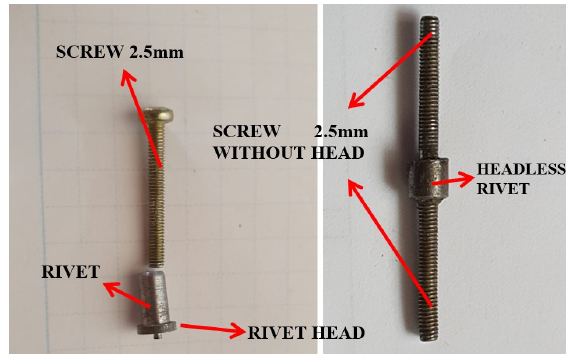
Figure 5. Connector assembly details. NOTE: on the left, screw and rivet before they are cut and connected; on the right, connector ready: two screws threaded and glued to a headless